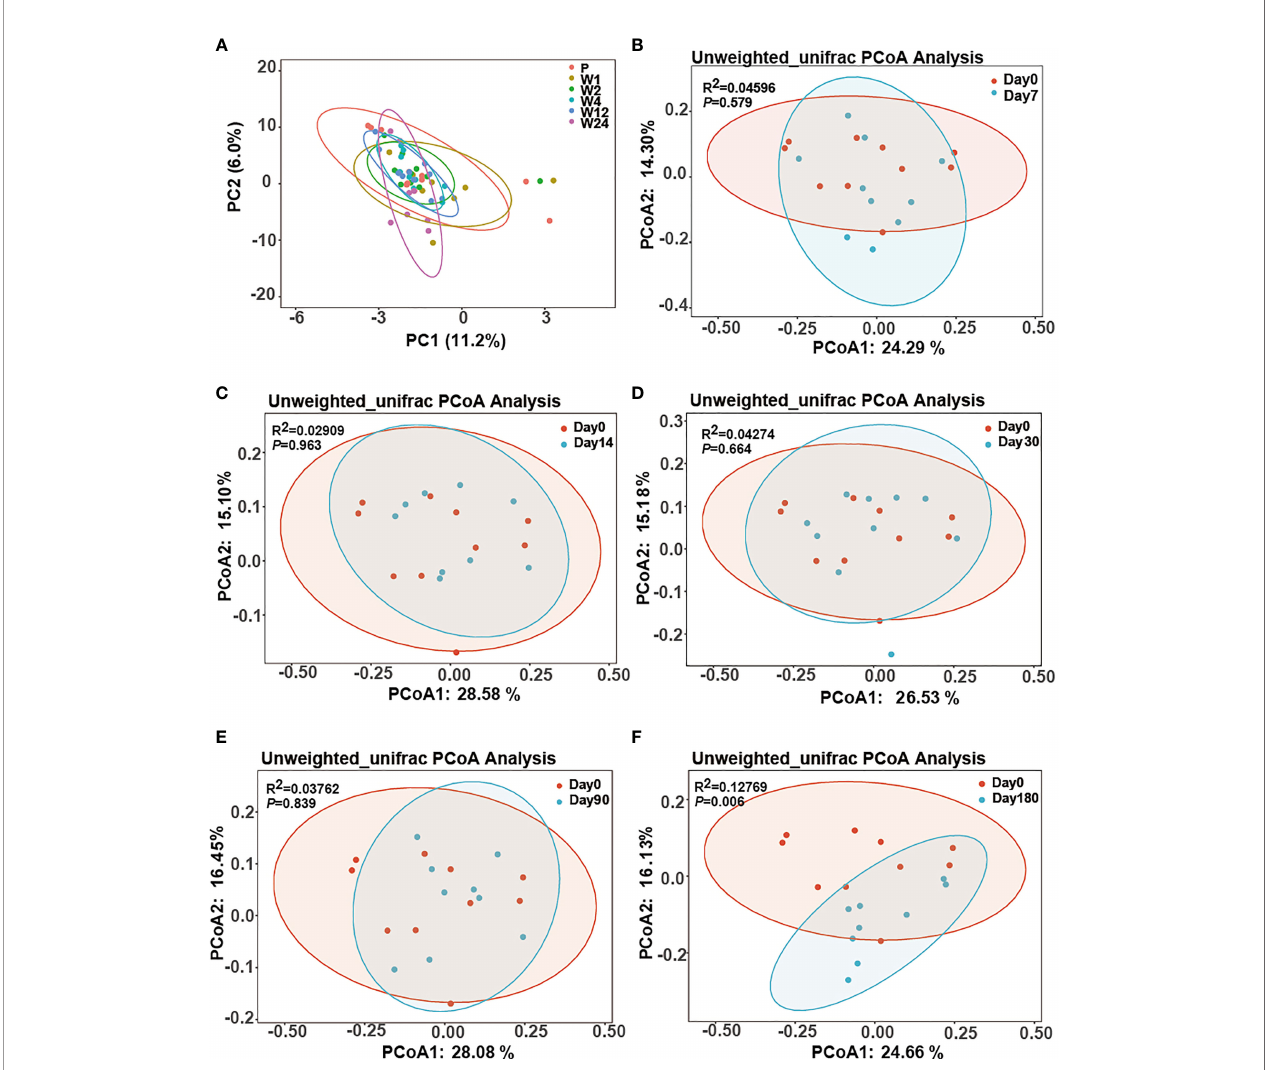
FIGURE 2 | The beta diversity of the GCFmicrobiota over time. (A) PCA (unconstrainedordination) of allsamples at the sixtime points. (B – F) Two-dimensional diagram of the principal coordinate analysis (PCoA) of unweighted UniFrac distance metrics of the ASV abundance data from the GCF sample of peri-implantitispatients across alltime points. Each sample representedby the smallcircleand ellipses represents the 95% con fi dence concentrated in infectious disease-related pathways ( Additional File 4: Table S4 ). The mean proportions of the infectious disease-related pathways in the after-treatment groups were all less than those in the pre-treatment group. All the pathways at KEGG level 3 showing signi fi cant difference between after treatment and day 0 are shown in Additional File 10: Figure S5 and Additional File 5: Table S5 .